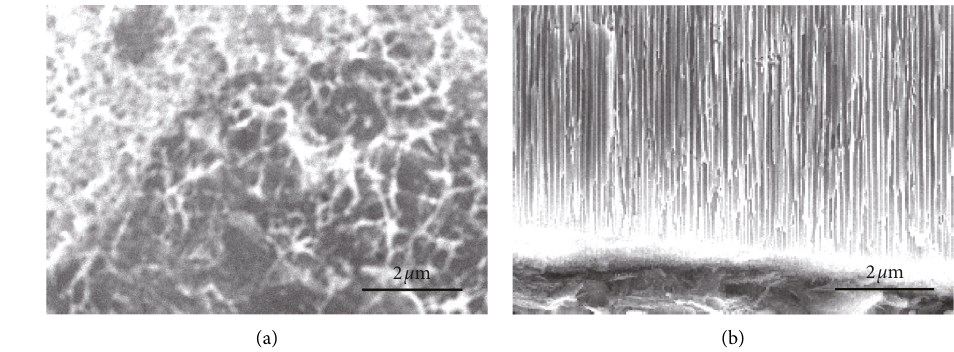
Figure 2: SEM images of (a) SPCE and (b) CuNW/SPCE.